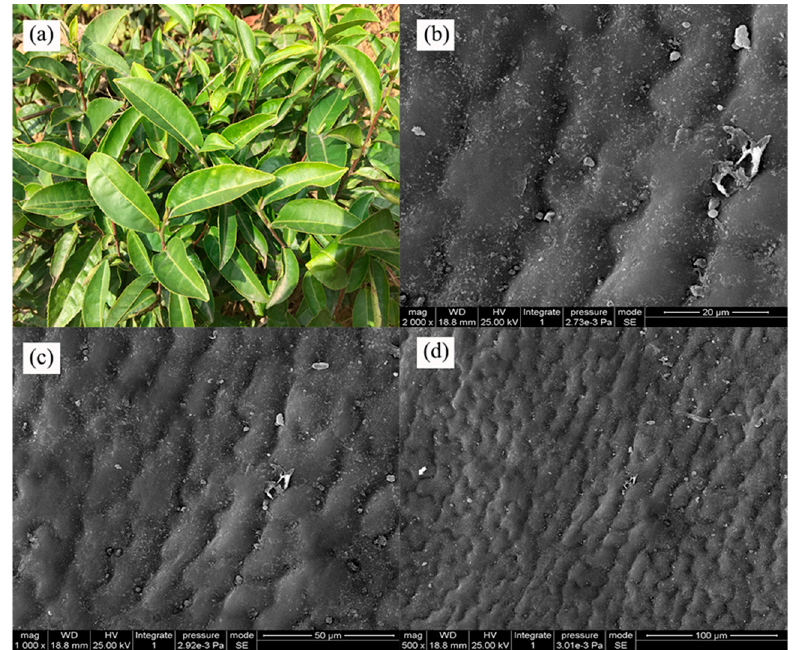
Figure 1. Tea leaves ( a ); scanning electron microscopy images of tea leaf surfaces ( b – d